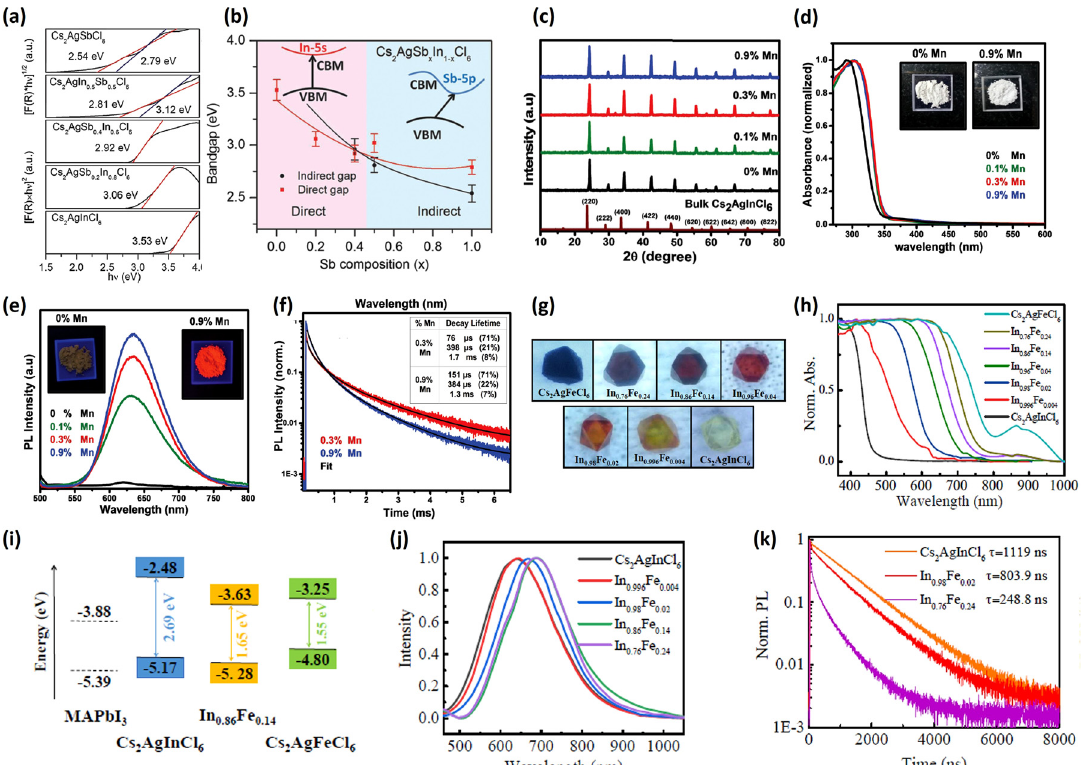
Figure 8: (a) Tauc plots for Cs 2 AgSb x In 1 − x Cl 6 ( x = 0, 0.2, 0.4, 0.5, 1) [92]. Copyright 2015, Royal Society of Chemistry. (b) Phase diagram